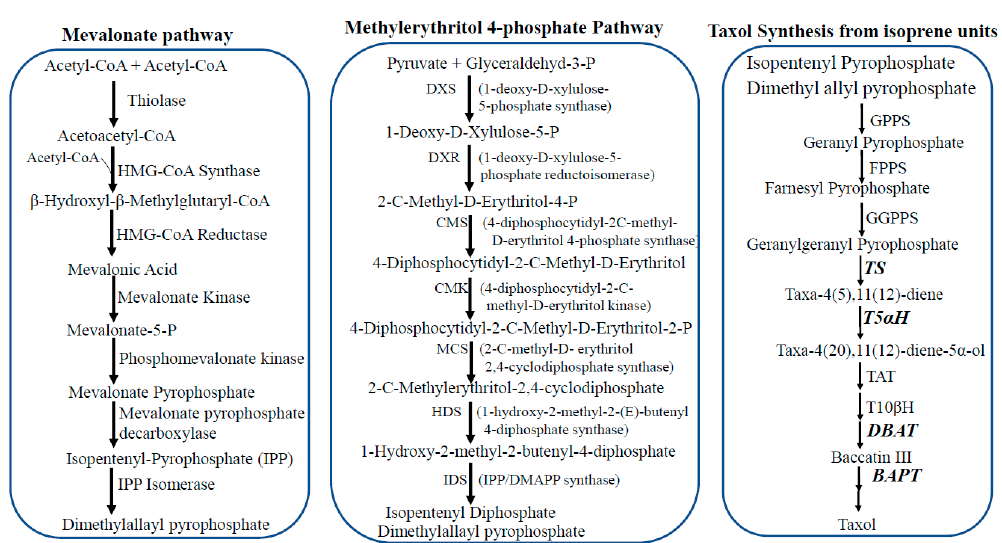
geranylgeranyl pyrophosphate (C20) (2) cyclization of GGPP by taxadiene synthase (TDS)